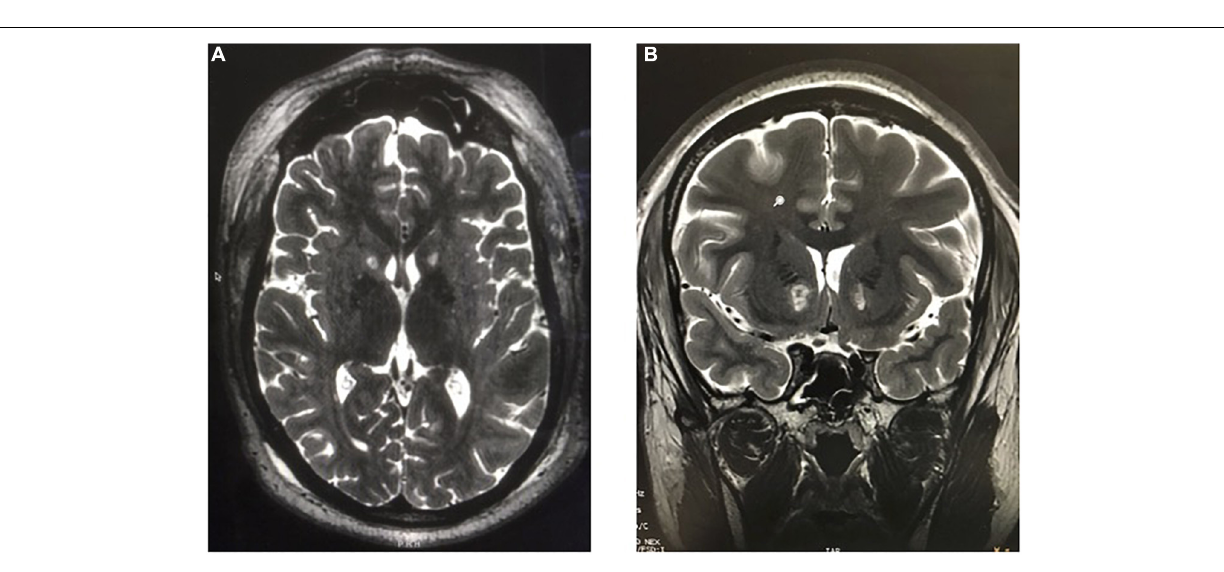
FIGURE 11 | MR-guided focused ultrasound capsulotomies (MRgFUS). (A) Axial T2-weighted and (B) Coronal T2-weighted MRI after bilateral MRgFUS